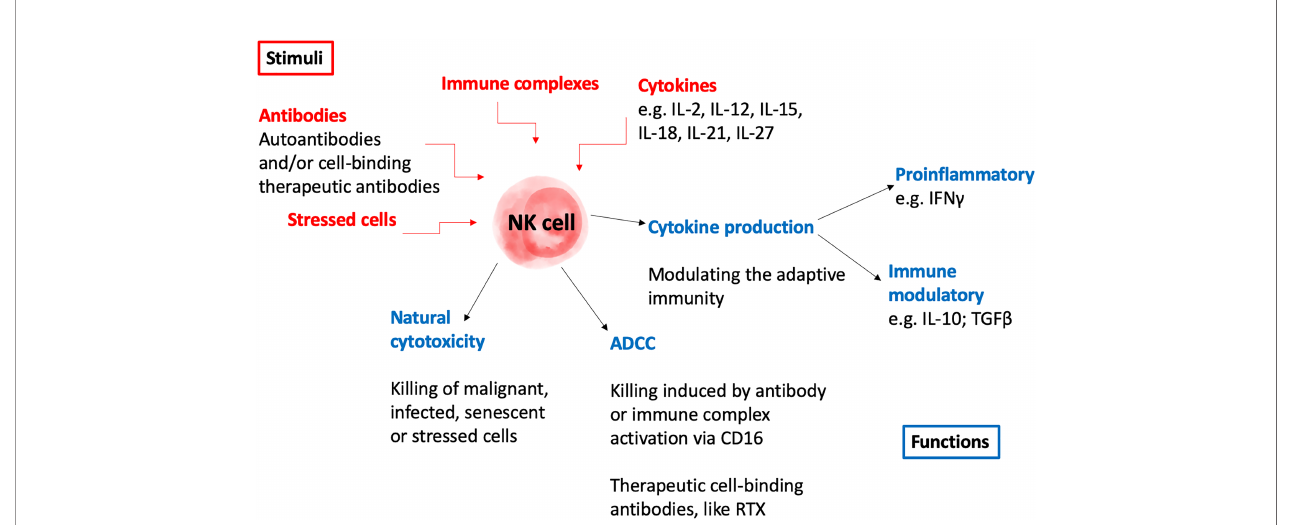
FIGURE 1 | Schematic illustration of potential roles of NK cells in the pathogenesis of autoimmunity. AAV, anti-neutrophil cytoplasmic antibody (ANCA)-associated vasculitis; ADCC, antibody dependent cellular cytoxicity; IFN g , interferon gamma; IL, interleukin; NK, natural killer; RTX, rituximab; TGF b , transforming growth factor